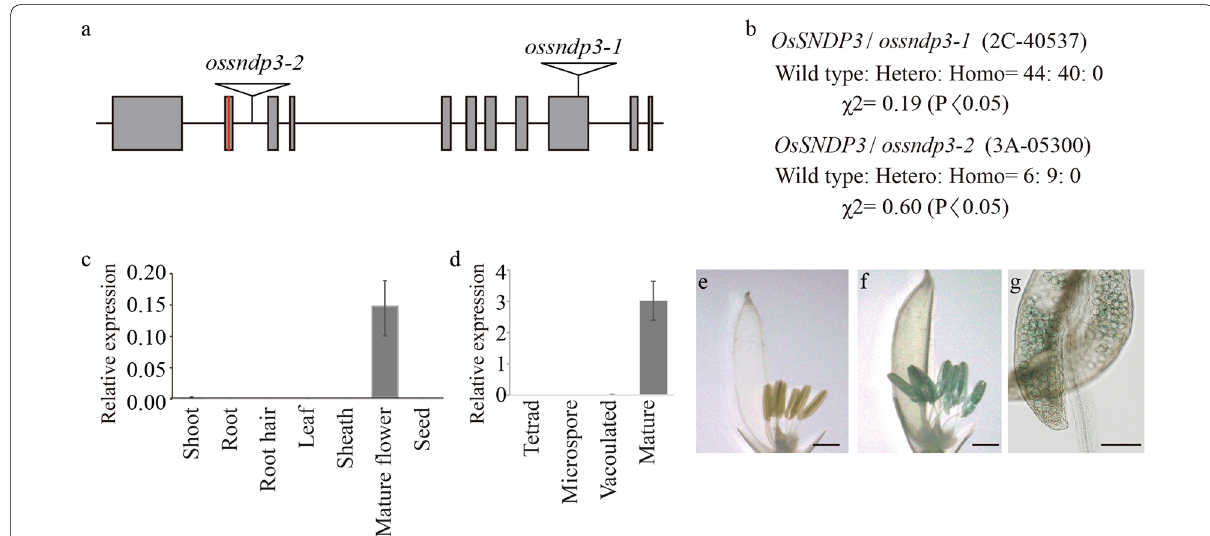
Fig. 1 The expression pattern of OsSNDP3 . a Schematic representation of OsSNDP3 including T‑DNA insertion and target region for gene‑editing. Grey boxes indicate exon; lines, intron; reverse triangles, T‑DNA; red box, target region of CRISPR/Cas9. b . Segregation analysis of OsSNDP3 / ossndp3-1 and OsSNDP3 / ossndp3-2 , and results of Chi‑square test (χ2) . RT‑qPCR analysis of OsSNDP3 in various tissues ( c ) and different stages of anther development ( d ). Histochemical GUS analysis of transgenic plants harboring p OsSNDP3 ::GUS vector. Pictures were taken from the vacuolated ( e ), mature ( f ), and anthesis stage ( g ) flowers. Bars 1 mm ( e and f ) and 500 µm ( g ) =